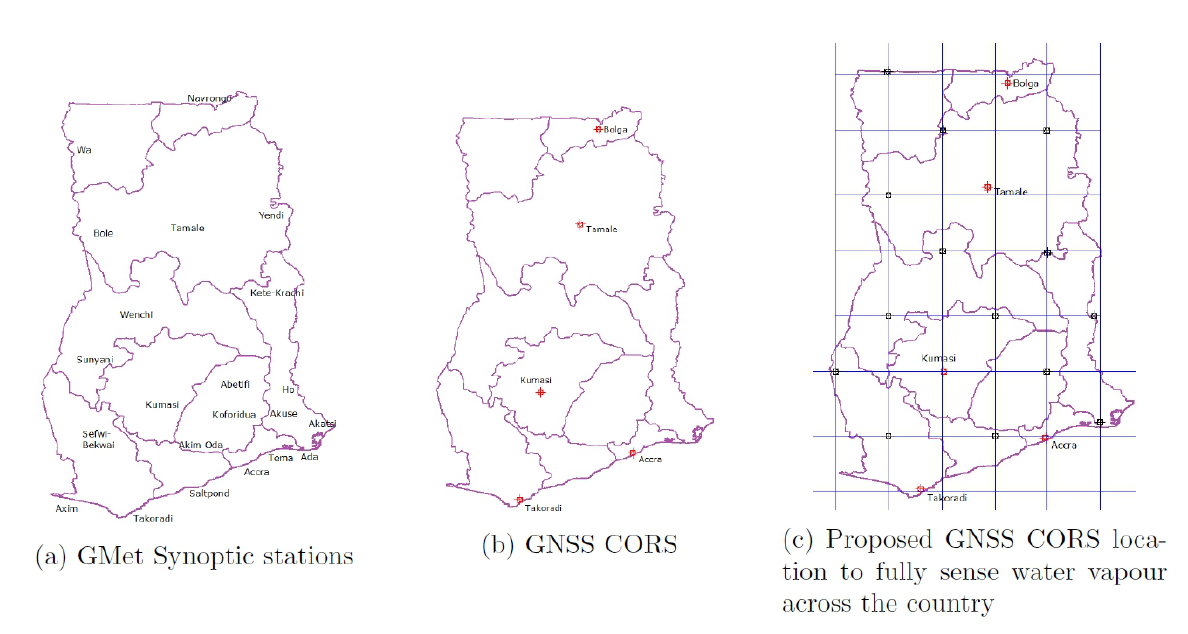
Figure 7: GNSS Meteorological Set-up in Ghana